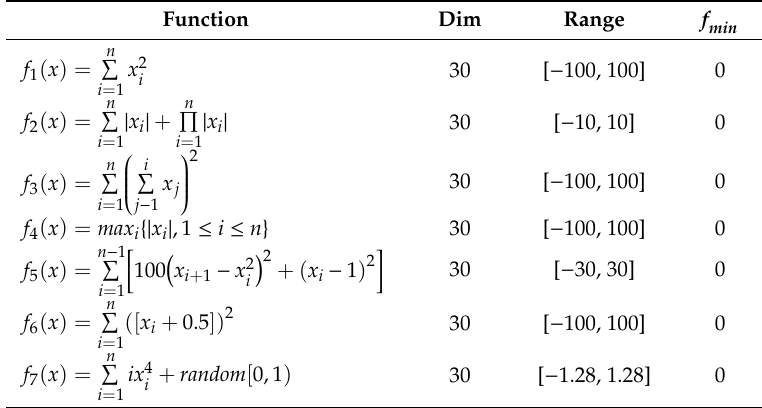
Table 2. Unimodal benchmark functions.